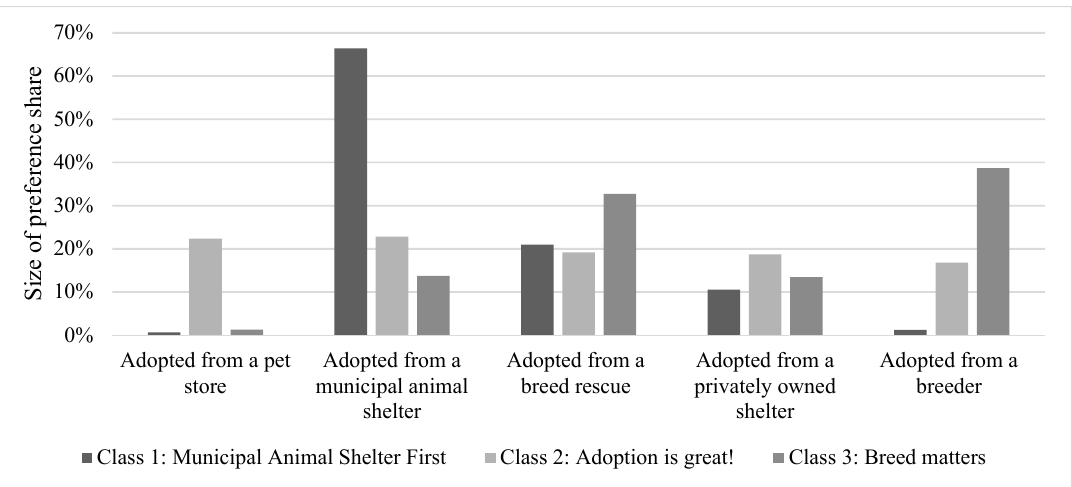
Figure 2. Latent class model preference shares for most ethical way to adopt a dog (n = 767).